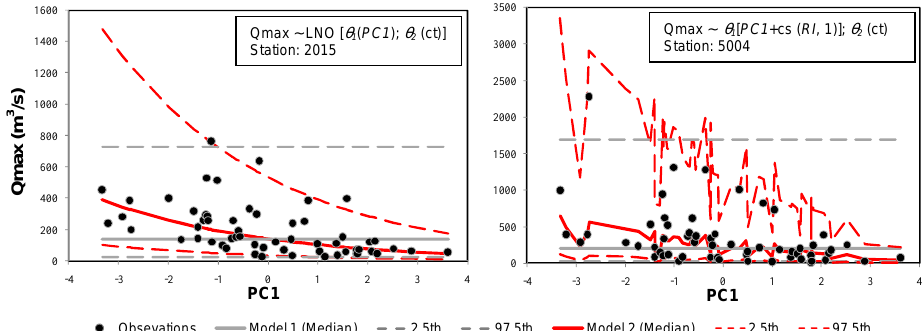
Figue 6. Estimates of the median and the 2 . 5th and 97.5th percentiles for models 0 and 1 plotted against 773 Fig. 6. Estimates of the median and the 2.5th and 97.5th percentiles for models 0 and 1 plotted against PC1 for two flow gauge stations with low (left) and high (right) altered PC1 for two flow gauge stations with low (left) and high (right) altered regime. 774